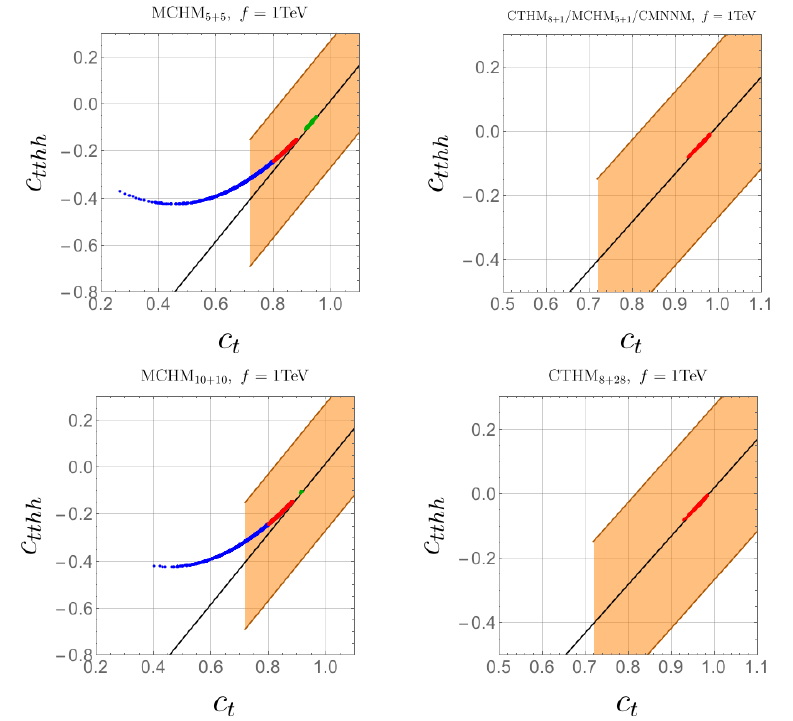
Figure 11 . The distribution of c tthh vs c t in models with low dimensional representations. The scale f is set to 1 TeV. In the MCHM, the green points predict c t > c g thus the model has the problem of triggering EWSB [50], while the blue points satisfy c g > c t . EWSB is automatically triggered in CTHMs. The black line represents the relationship between c t and c tthh in eq. (6.2). The orange block represents the relation of eq. (6.3) with c W and c t within 2 (cid:27) uncertainties